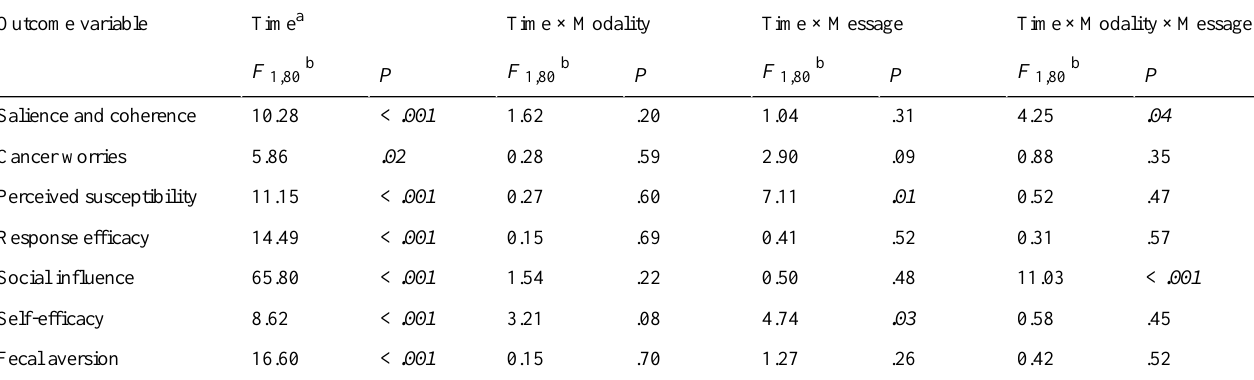
Table 7. Repeated measures ANOVAs comparing pre- and post-intervention group